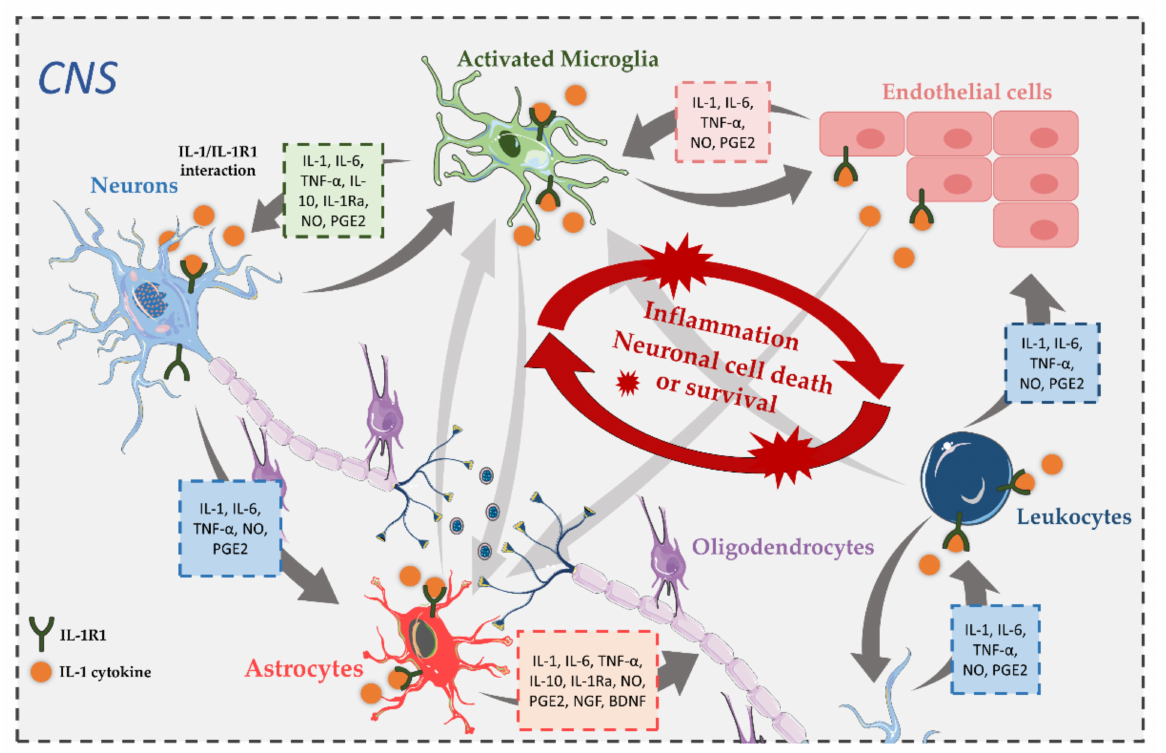
Figure 3. CNS cellular communication of IL-1 signaling in neuronal injury. In the normal brain, the expression of IL-1 is low, although acute CNS injury causes a sharp increase in IL-1 production. Different CNS cell types express IL-1R1, thereby enabling them to respond to IL-1 β in an autocrine manner, as well as in a paracrine manner, after neuronal injury. Upon IL-1/IL-1R1 interactions, these different cells can produce a wide range of pro-inflammatory and immune-regulatory mediators that contribute to neuronal death or survival through different signal transduction pathways. The figure was prepared using Servier Medical Art. Figure abbreviations: CNS, central nervous system; IL-1, interleukin-1; IL-6, interleukin-6; IL-10, interleukin-10; IL-1Ra, interleukin-1 receptor antagonist; IL-1R1, interleukin-1 receptor type 1; TNF- α , tumor necrosis factor- α ; NO, nitric oxide; PGE2, prostaglandin E2; NGF, nerve growth factor; BDNF, brain-derived neurotrophic